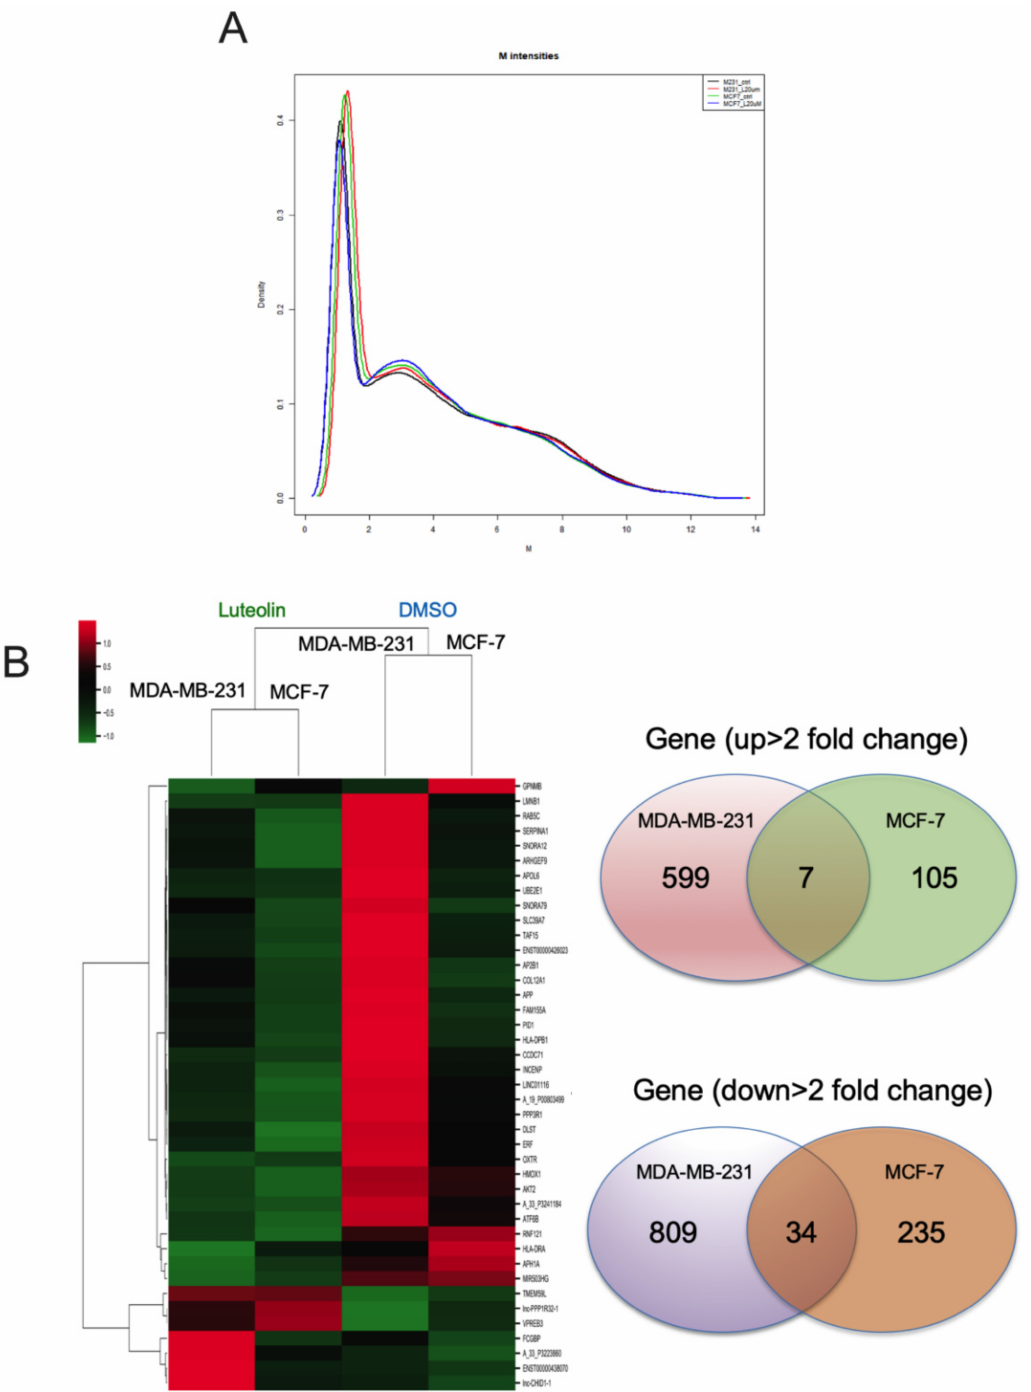
Figure 3. Fold changes in mRNA expression in luteolin-treated breast cancer cells. ( A ) Signal distribution across the ChIP channel in the density plots. ( B ) Heatmap visualization of the gene microarray analysis results illustrating the differentially expressed genes (total 1789 genes) with fold changes > ± 2.0. Venn diagram of genes illustrating that luteolin mediated 711 genes that were upregulated and 1078 genes that were downregulated in breast